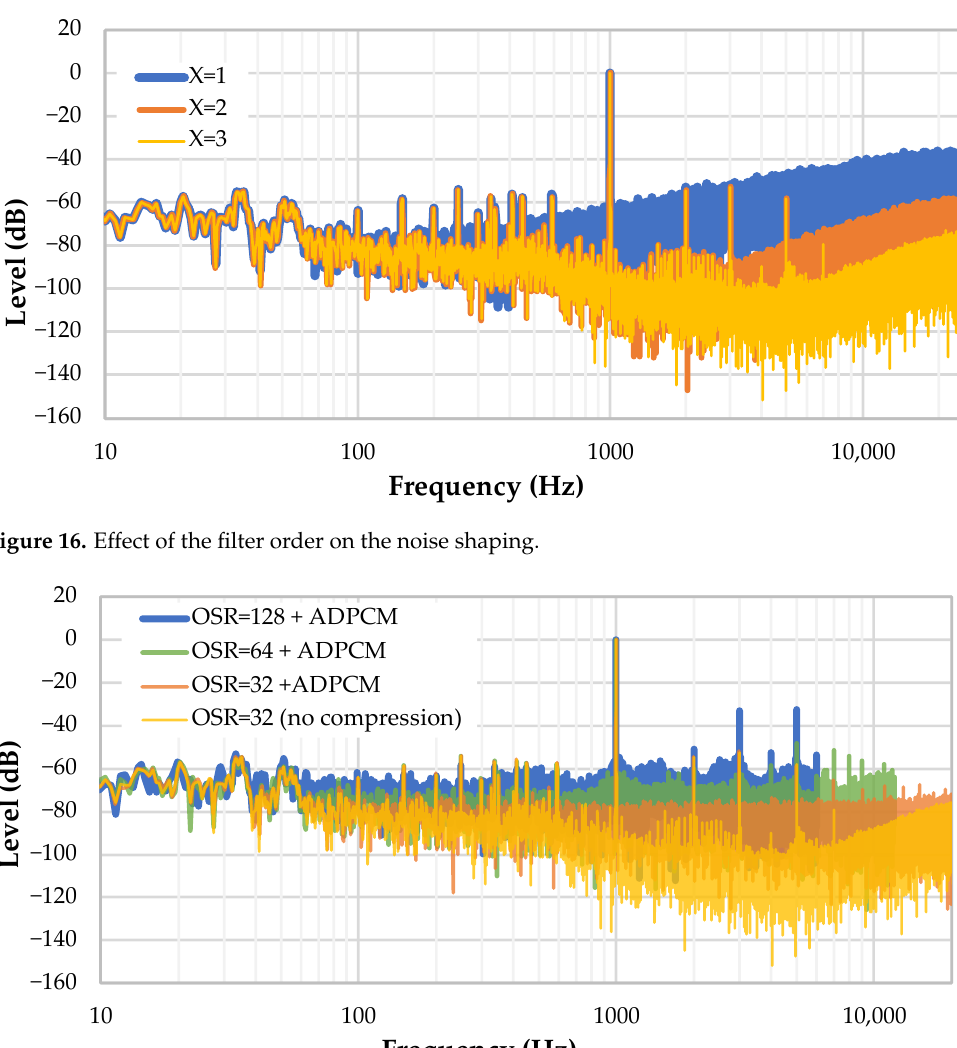
Figure 18. Example of time-aligned recorded data.